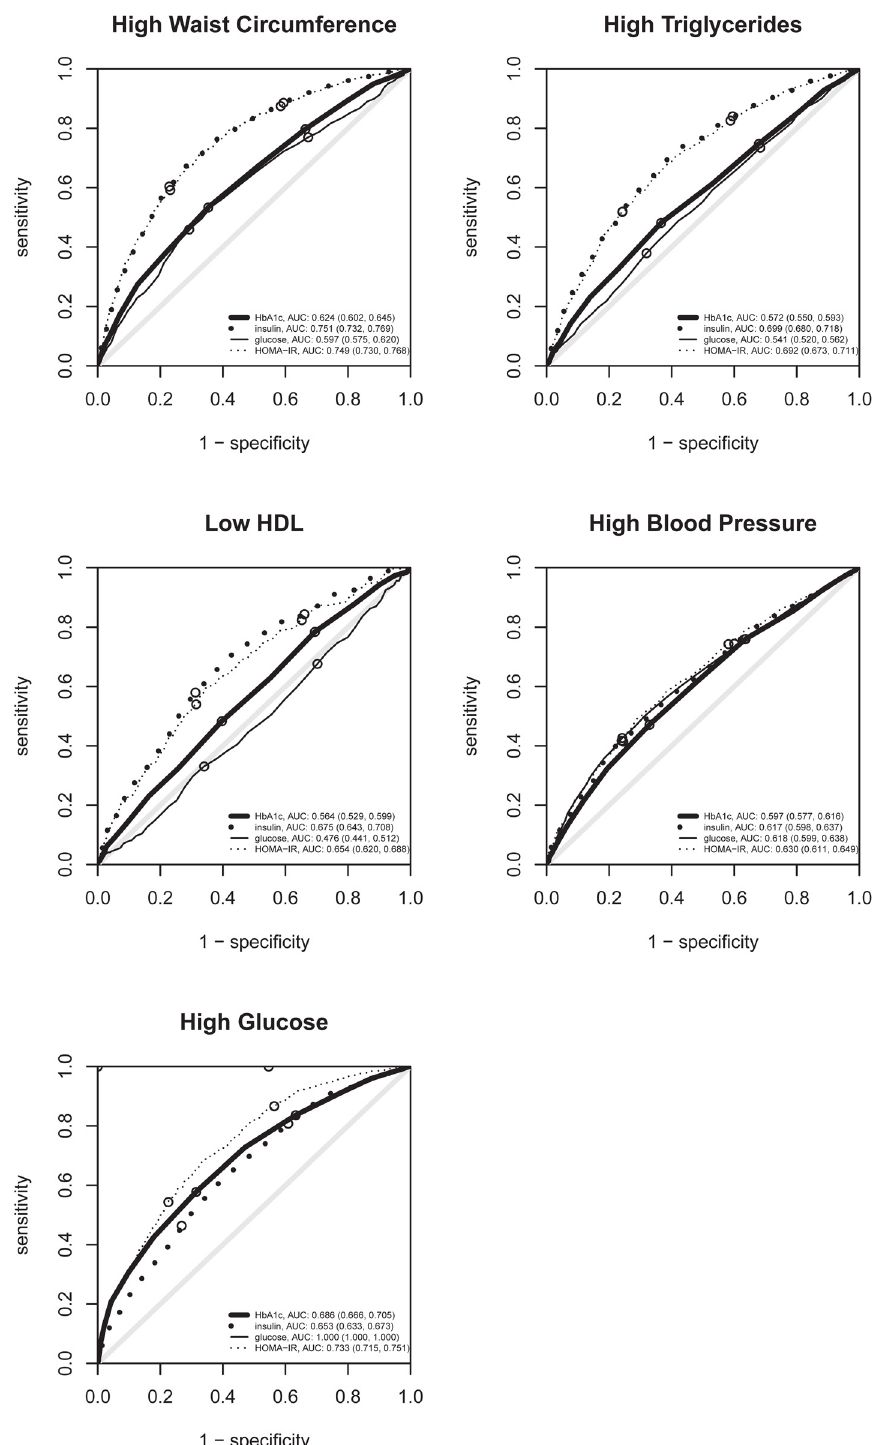
Fig 1. ROC curves of HbA1c, insulin, glycemia and HOMA-IR for metabolic syndrome criteria. ROC curves for detecting individually each metabolic syndrome criteria. The small circles indicate the sensitivity and specificity when using the tertiles of each variable as cut-offs. For high glucose, the glycemia curve can not be seen as it lies exactly at the left and upper borders.